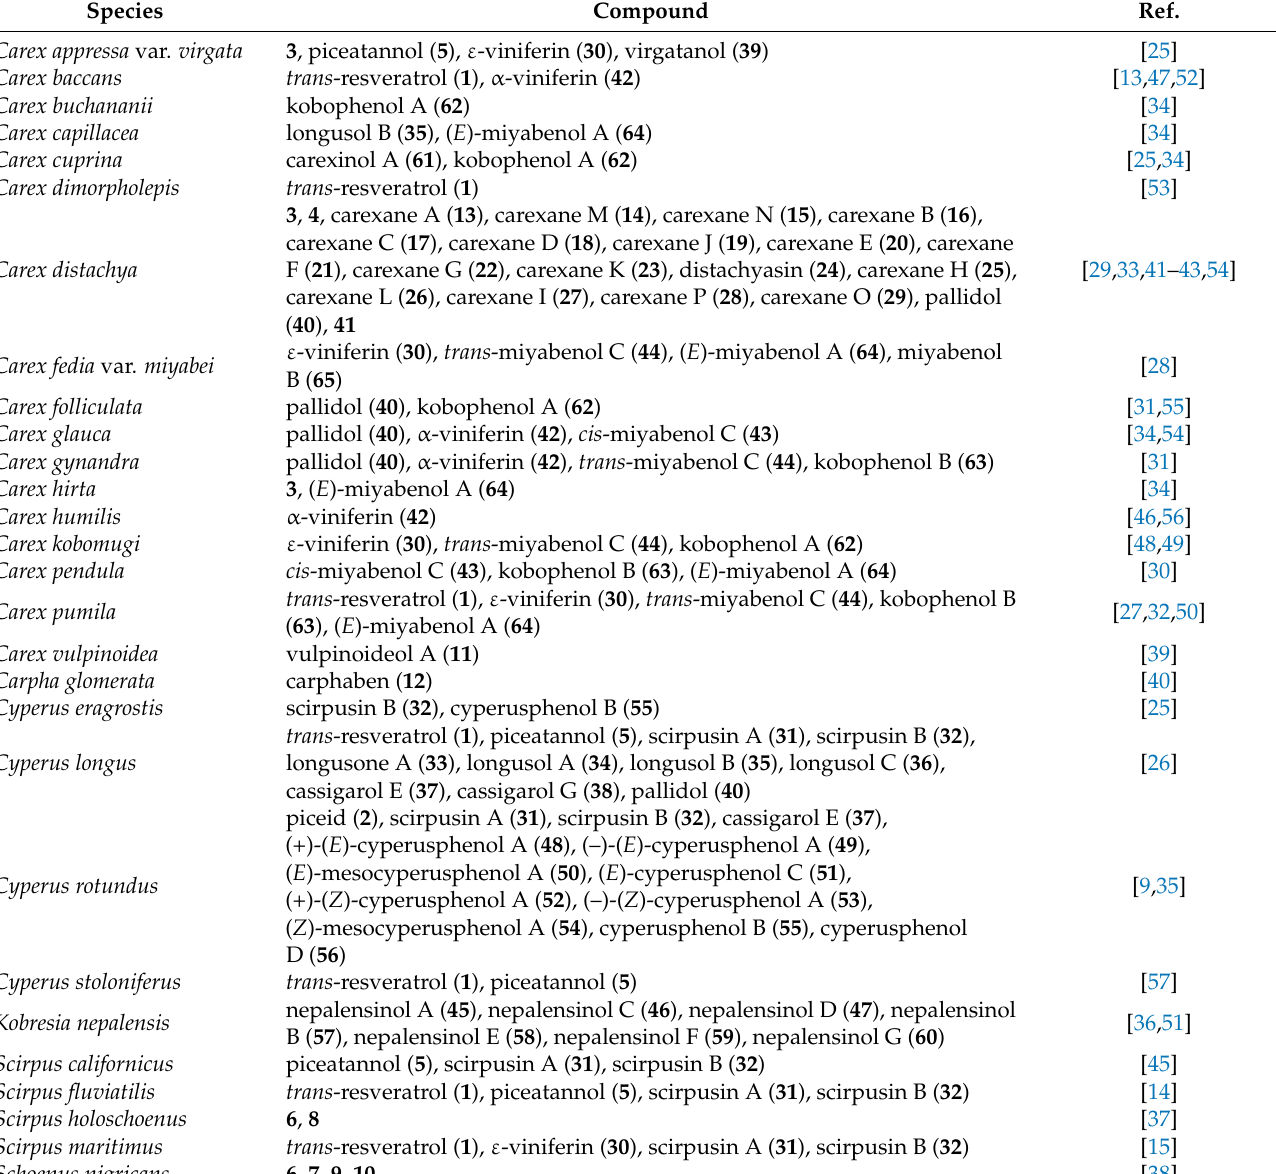
Table 1. Stilbenoids of Cyperaceae